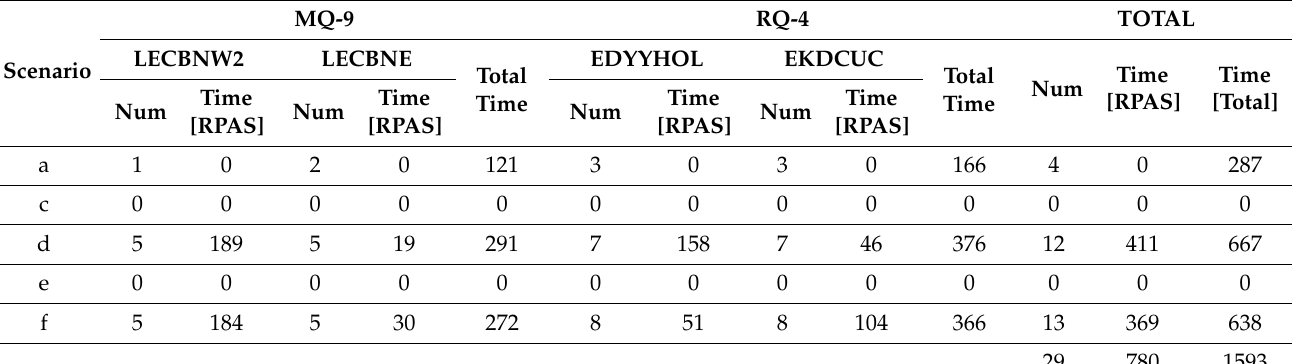
Table 6. Resume table of the contingency-related RPAS/ATC real-time simulations